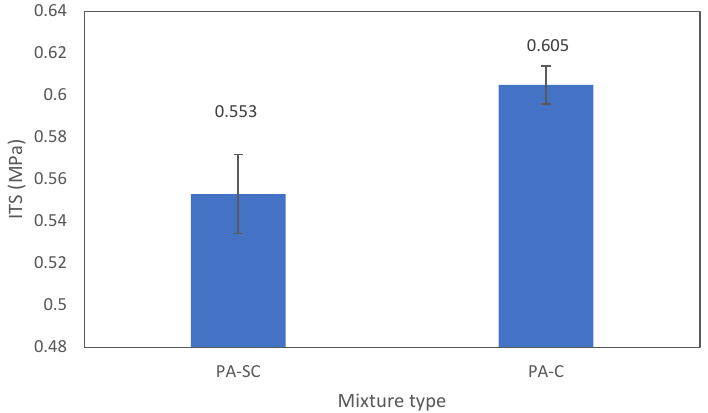
Figure 3. Average ITS for porous samples.